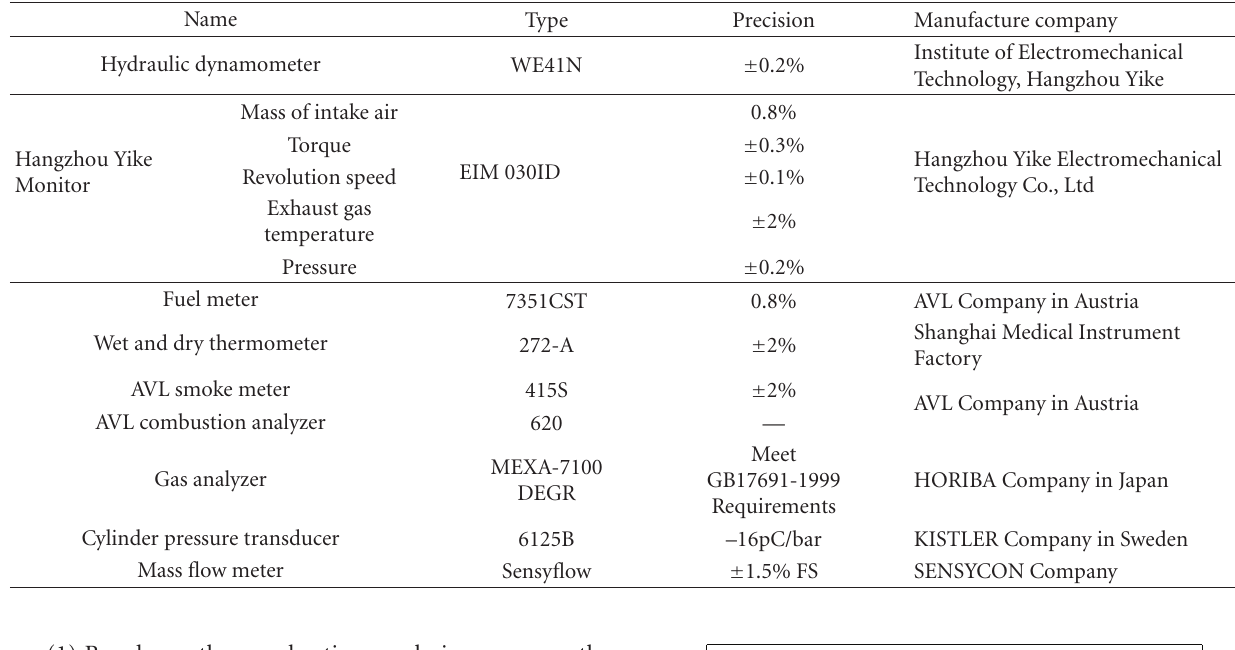
Table 3: Specifications of the experimental apparatus.